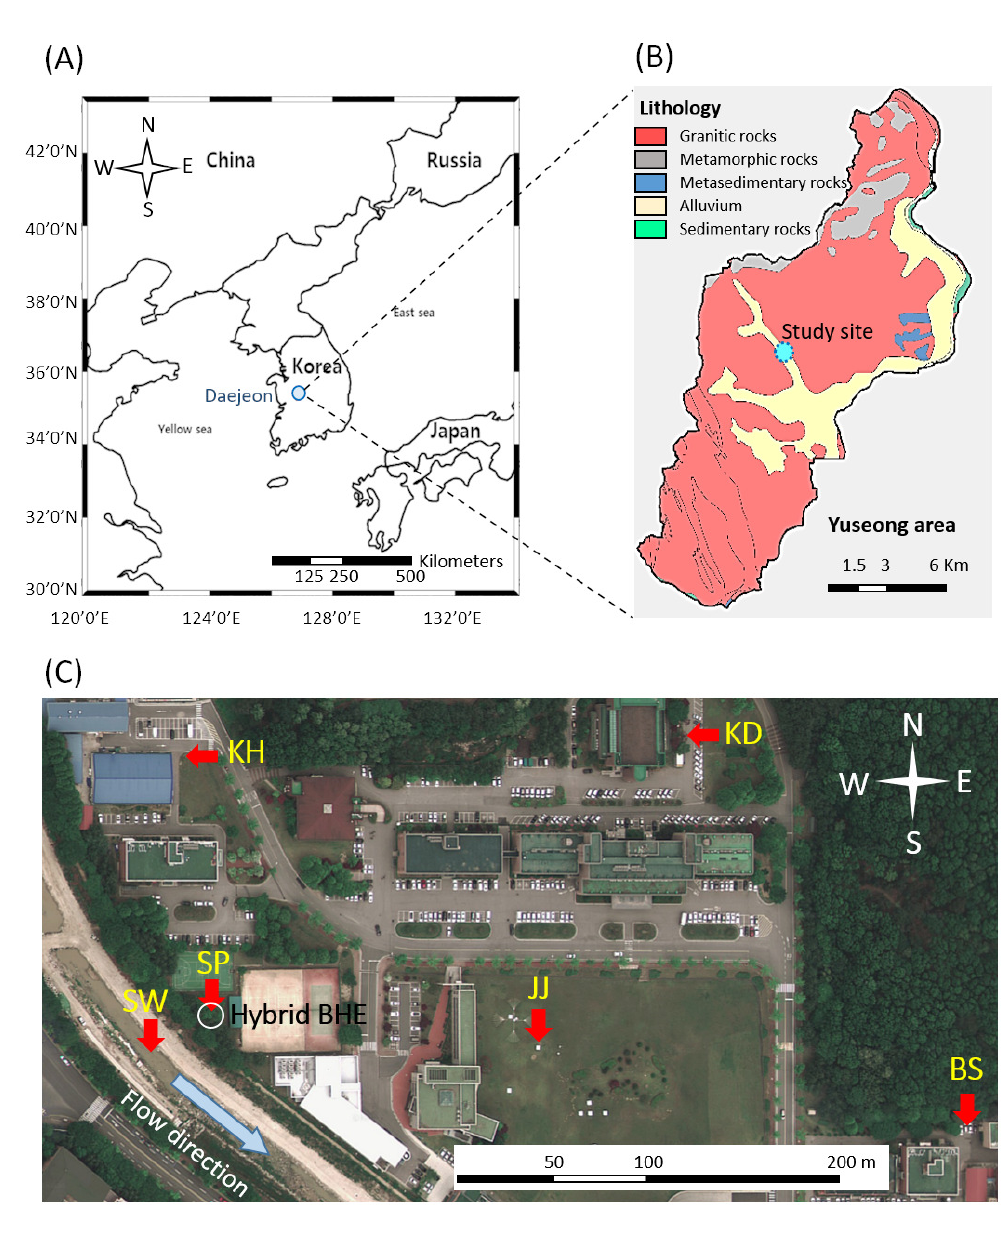
Figure 1. Location ( A ), geology ( B ), and sampling sites ( C ) of the study